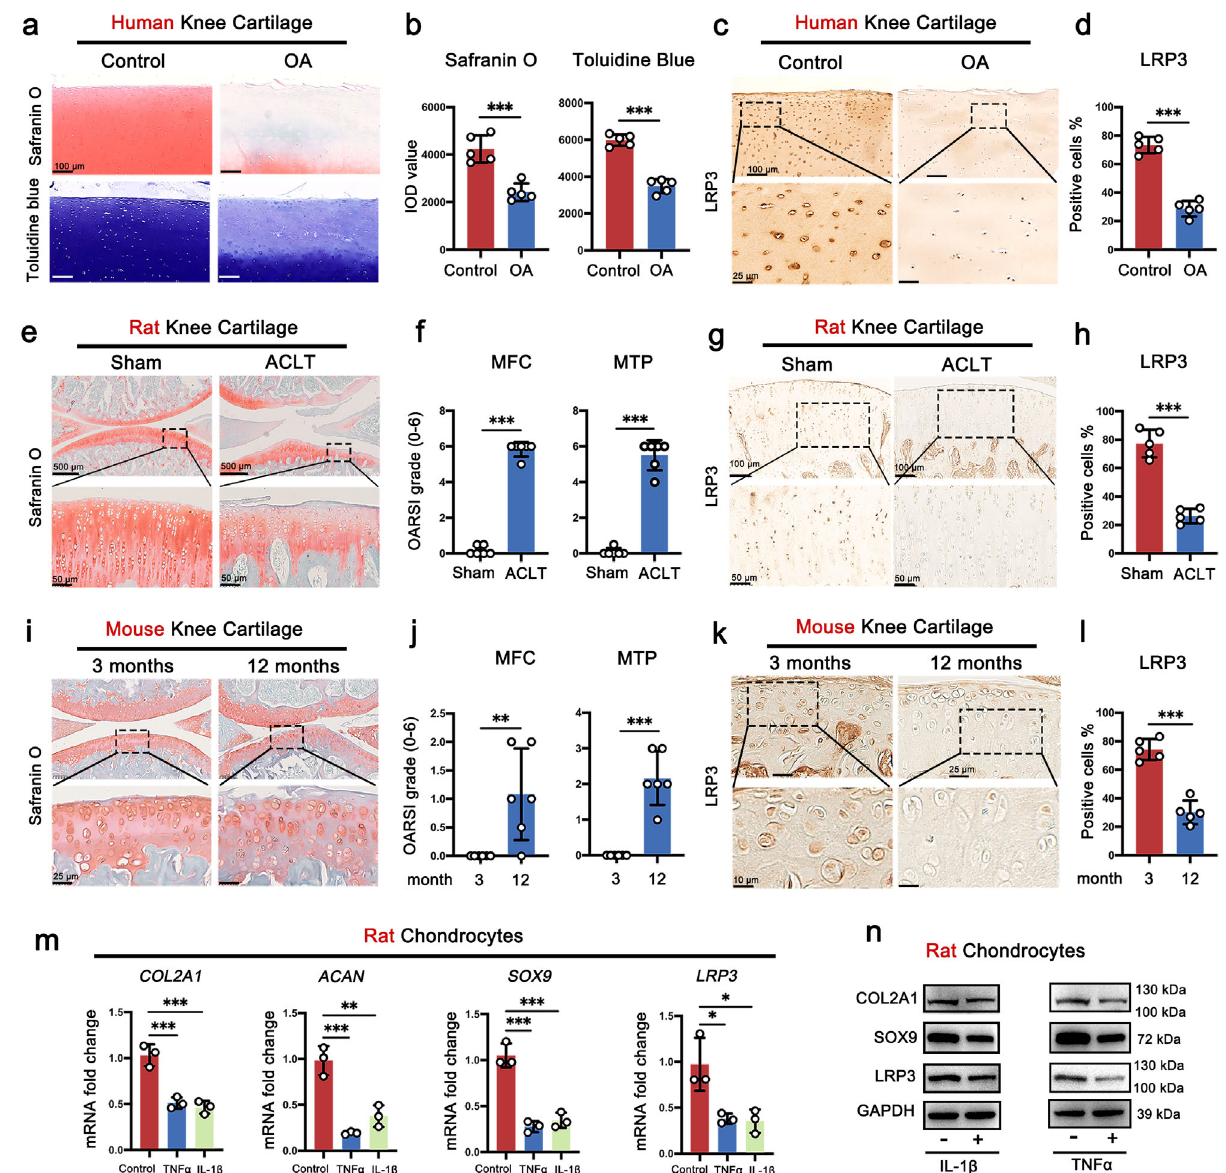
Fig.3|TheexpressionofLRP3isdecreasedduringOAdevelopment.a Safranin- O and toluidine blue staining in human OA and normal cartilage ( n =5). b The IOD value for human cartilage proteoglycan content determined by safranin O and toluidine blue staining ( n =5,two-tailedStudent ’ s t -test). c IHCstaining forLRP3 in human OA and normal cartilage ( n =5). d Quanti fi cation of LRP3-positive cells in imagesofsafraninO-fastgreenstaininginratShamandACLTkneecartilage( n =5). f OARSI scores of rat Sham and ACLT knee cartilage ( n =5, two-tailed Student ’ s t